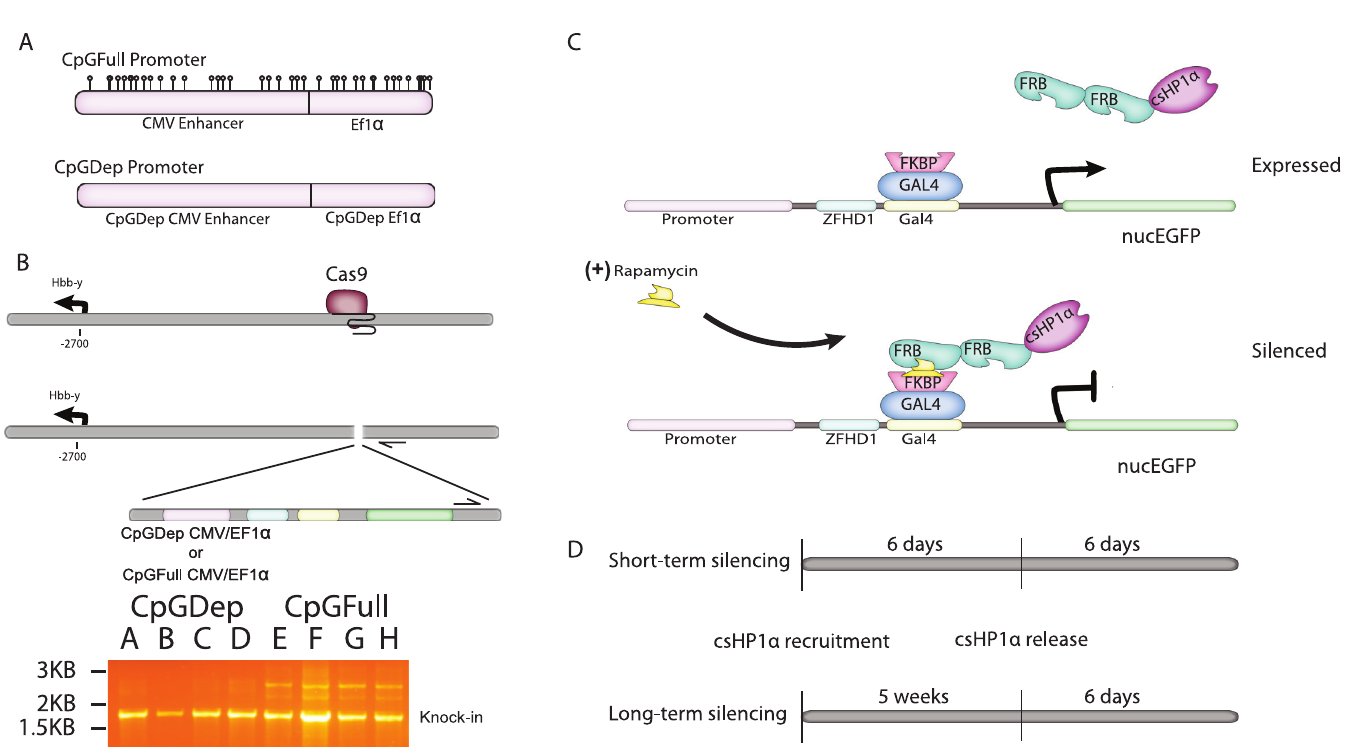
Fig 1. Creation of CpGDep and CpGFull reporter cell lines to test effects of CpG dinucleotide content on the kinetics of HP1-induced heterochromatization and gene silencing. A) The wildtype CMV/EF1 α promoter has 39 total CpG dinucleotides, represented by lollipops, while the CpGDep is completely devoid of CpG sites. B) GFP-expression cassettes are driven by the CpGDep or CpGFull promoters inserted into an intergenic region outside of the Balb/C β -Globin locus using CRISPR/Cas9 targeted insertion. Verification of successful knock-in was performed by PCR. PCR primers are indicated by black arrows and can be found in Table 1. C) The CiA system uses CIP-rapamycin to recruit csHP1 α to the reporter gene in a reversible manner. D) The timeline for “short-term” silencing is six days of csHP1 α recruitment, followed by washout of rapamycin and addition of FK506. “Long-term” silencing is characterized by five continuous weeks of csHP1 α recruitment before CIP washout.